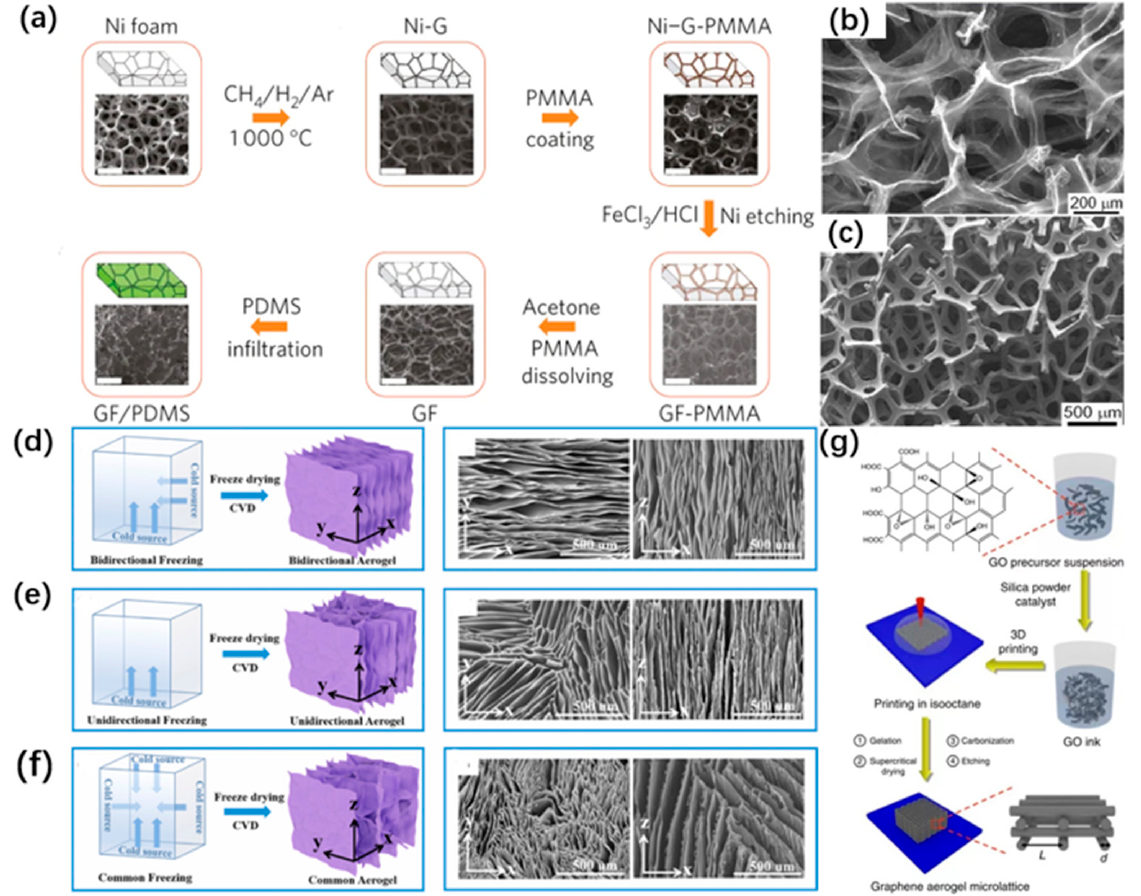
Figure 4. ( a ) CVD growth of 3D graphene using nickel foam as a template [9]; ( b ). SEM image